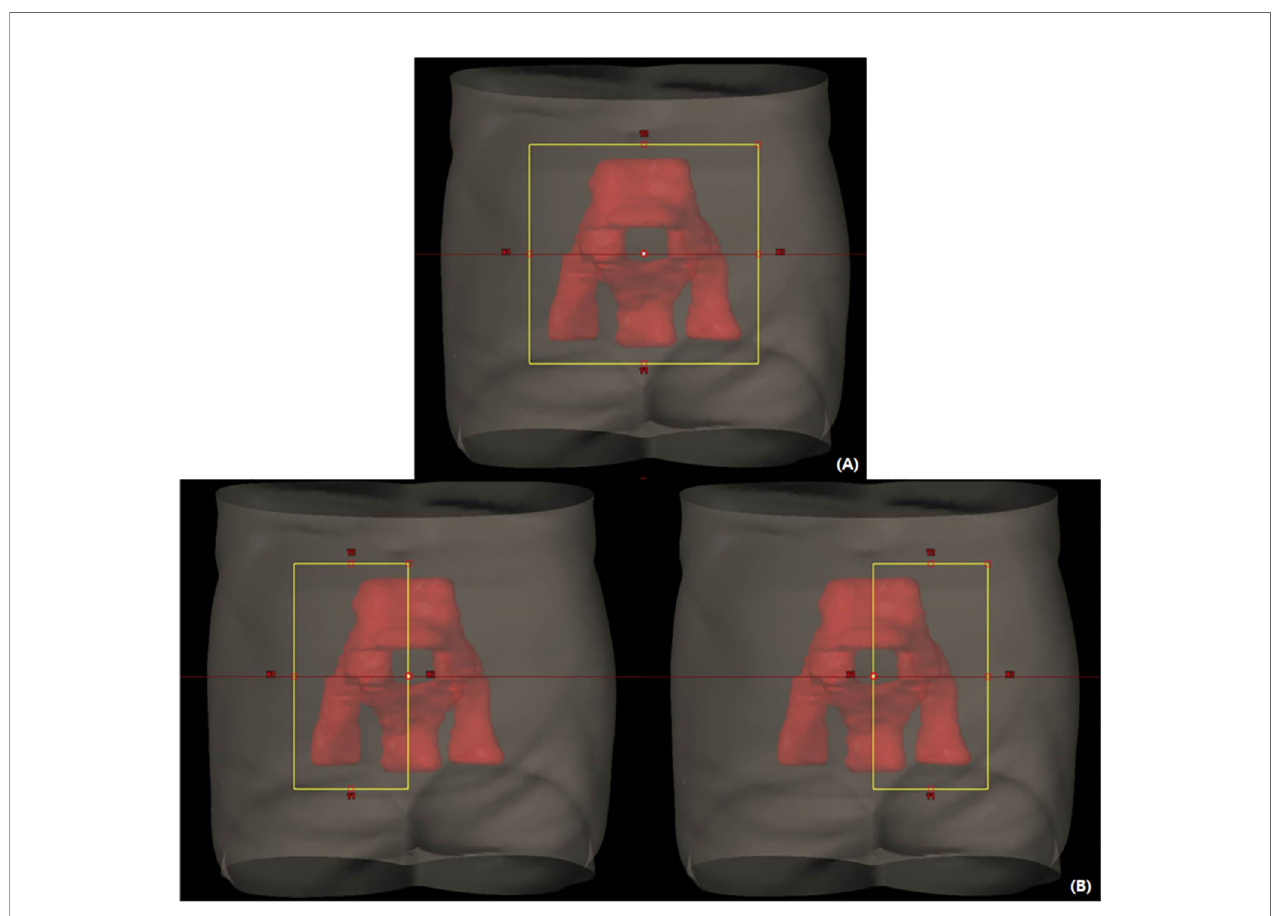
FIGURE 1 | Volumetric modulated arc therapy (VMAT) plans optimized with different fi eld sizes for whole pelvic radiation therapy. (A) A fully opened fi eld size (FF) to suf fi ciently cover a planning target volume in a beam ’ s eye view across arc angles. (B) Half of the FF size for each arc rotating clockwise and